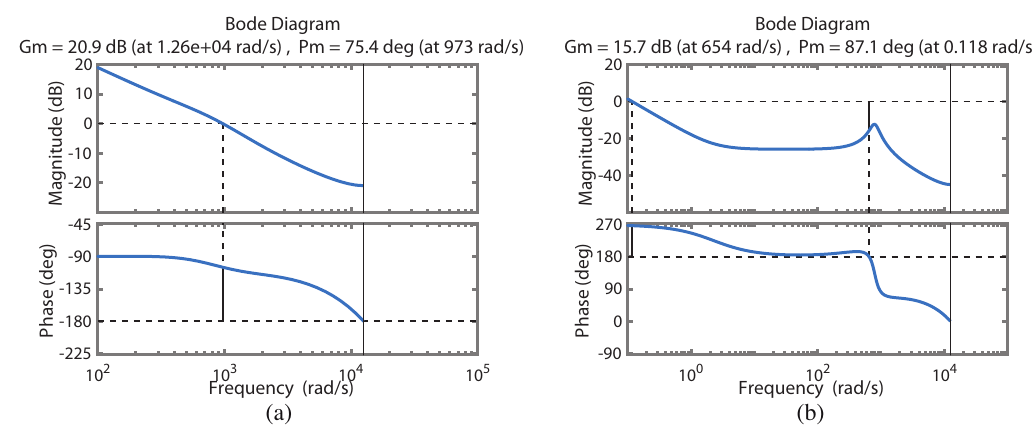
Figure 12. Open-loop Bode diagrams when operating at: ( a ) V pv = V oc ; and ( b ) V pv = V MPP